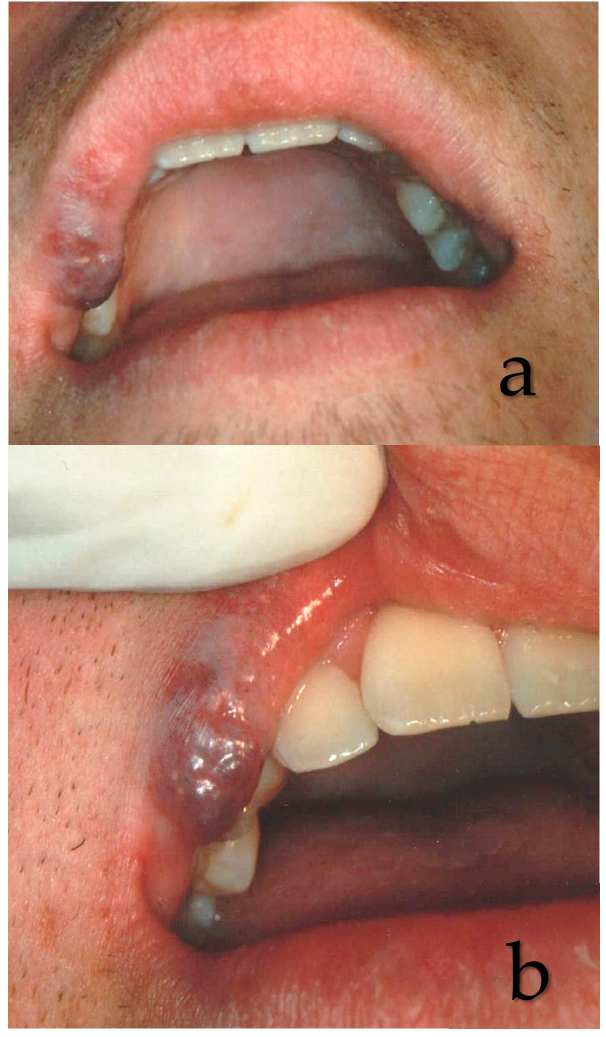
Figure 4. ( a,b ) Clinical aspects of capillary hemangioma (CH) of the upper lip. The lesion was a result of a trauma.